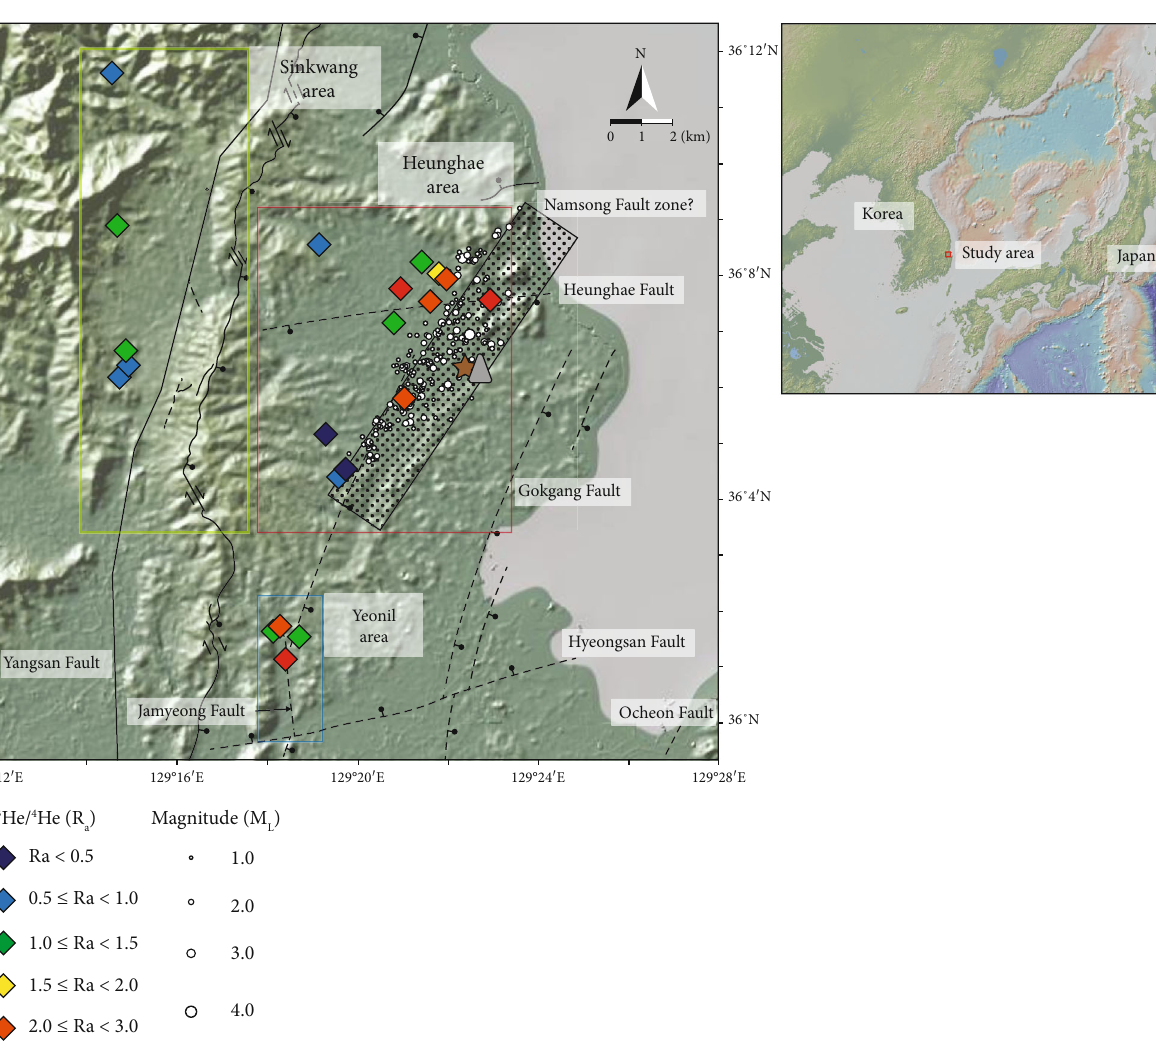
Figure 1: Geological map of Pohang, South Korea (modi fi ed from Song [14]), created by GeoMapApp 3. 6. 10 [52]. Sample locations are marked with diamond symbols. Each symbol is represented by a helium isotope ratio ( 3 He/ 4 He). The location and scale (white circle) of aftershocks until 2017 are excerpts from the 2017 annual report of earthquakes published by the Korea Meteorological Agency (KMA). The gray triangle represents the EGS site, and the brown star stands for the epicenter of the Mw 5.5 earthquake that occurred